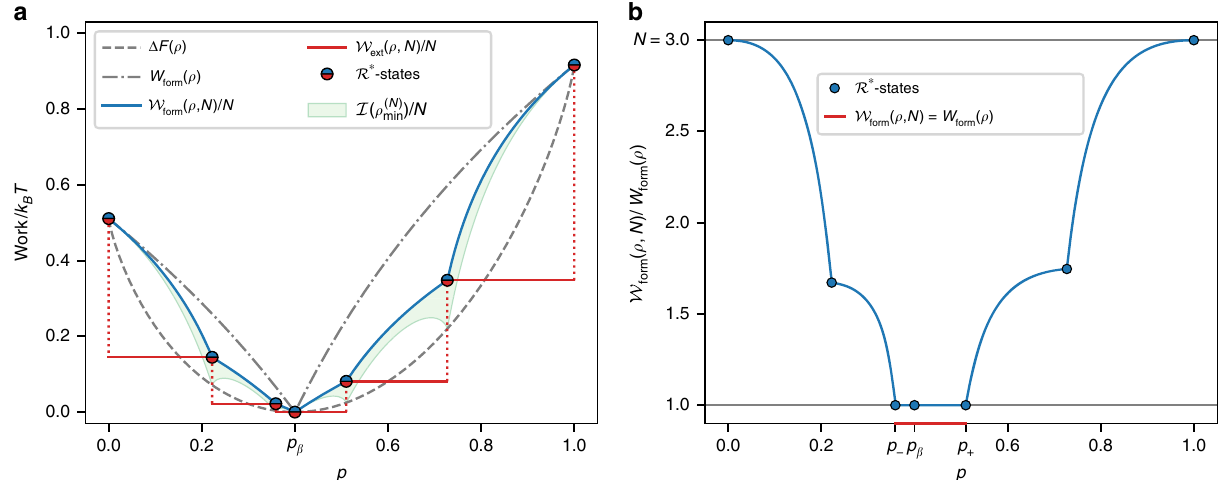
Fig. 2 Minimum work of formation of three correlated copies for the different local qubit states. a Different measures of work as a function of the local qubit state, ρ = (1 − p )|0 〉〈 0| + p |1 〉〈 1|, parametrized by the excited state probability p . For one copy, the work of formation W form ( ρ ) (gray dash-dotted lines) is bigger than the standard free energy difference Δ F (gray dashed lines). On the other hand, the minimum work of formation of correlated copies ( c -work of ρ ; N Þ = N (blue solid line), is smaller than or equal to W ρ ) but still greater than Δ F ( ρ ). W ρ ; N Þ = N (red solid line) is the formation) per copy, W form ( form ð ext ð ρ ; N Þ < W ρ ; N Þ , there are extractable work per copy of the optimal correlated state ρ ð N Þ . While in general all the correlated states are irreversible, W ext ð form ð min ρ ; N Þ ¼ W ρ ; N Þ , this is the set of R (cid:9) -states (reversible optimal states). The green region represents the total states (dots) whose ρ ð N Þ satis fi es W ext ð form ð min = N present in each multipartite state. b Ratio between the c -work of formation and the work of formation of a single correlations per copy Ið ρ ð N Þ min Þ